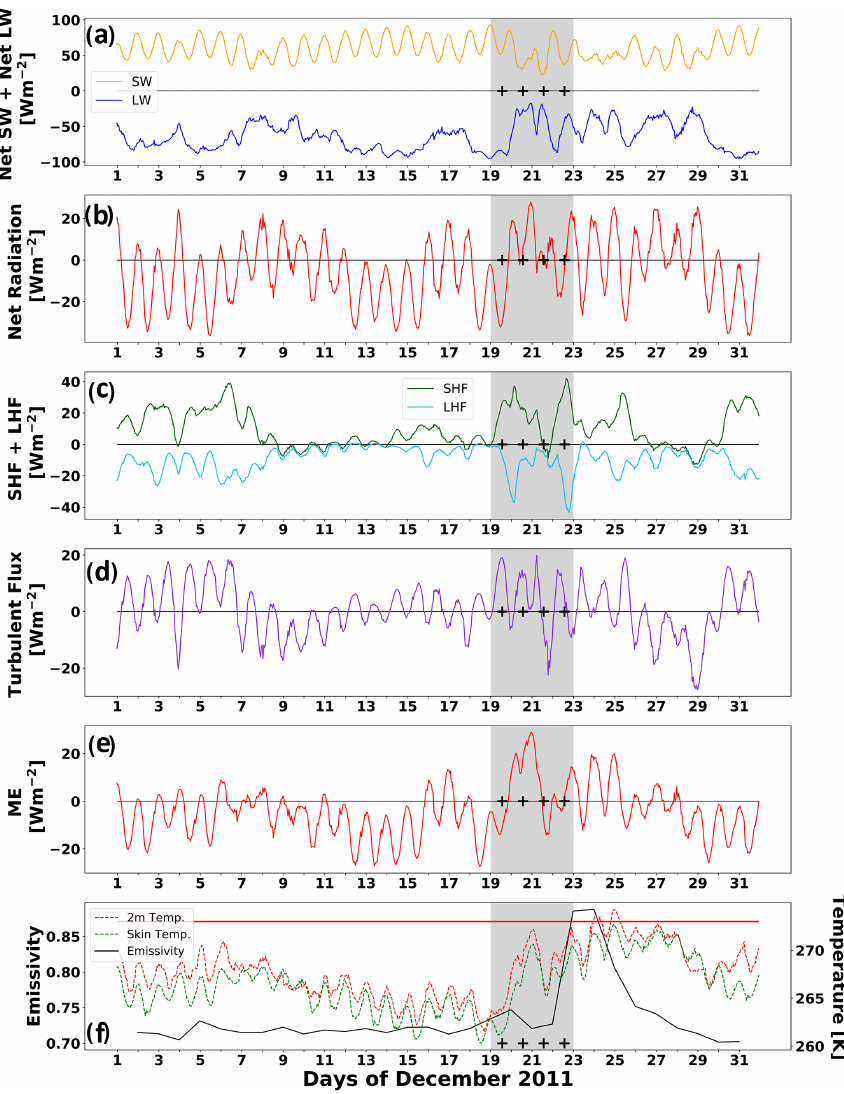
Figure 20. As in Fig. 4 but over the RIS region containing the Tom and Sabrina AWSs throughout December